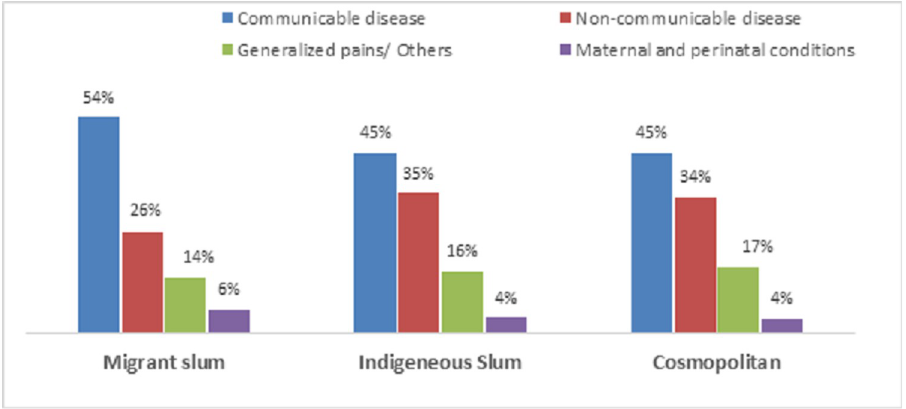
Fig 1. Percentage distribution of presenting medical complaints for in-patient and out-patient services in three urban slums in Nigeria. Source: Drawn by the authors from data collected in the survey for the